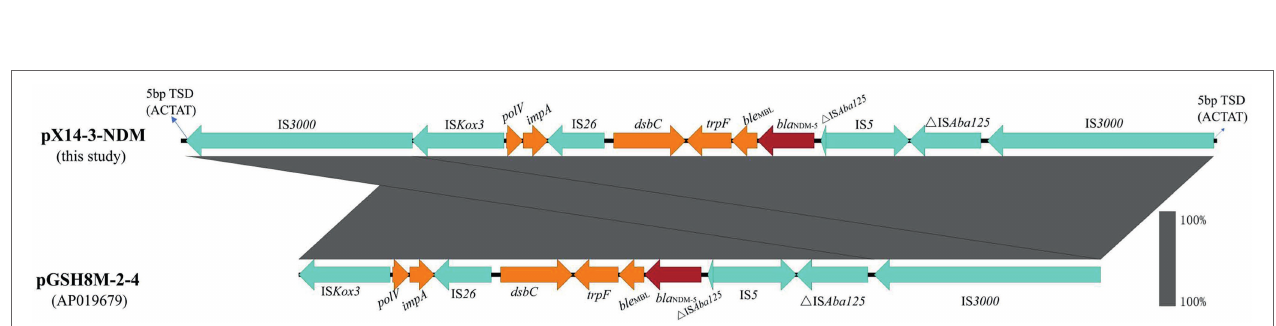
FIGURE 2 | Genetic environment of bla NDM-5 . Red, cyan, and yellow arrows denote antimicrobial resistance genes, mobile elements, and other genes, respectively. TSD, target site